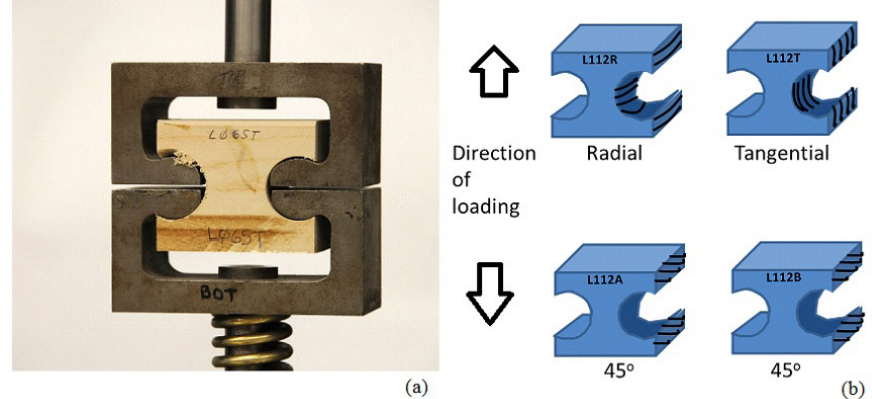
Figure 3. The test setup for tension perpendicular to grain testing (a); the direction of loading and specimen orientations (b).